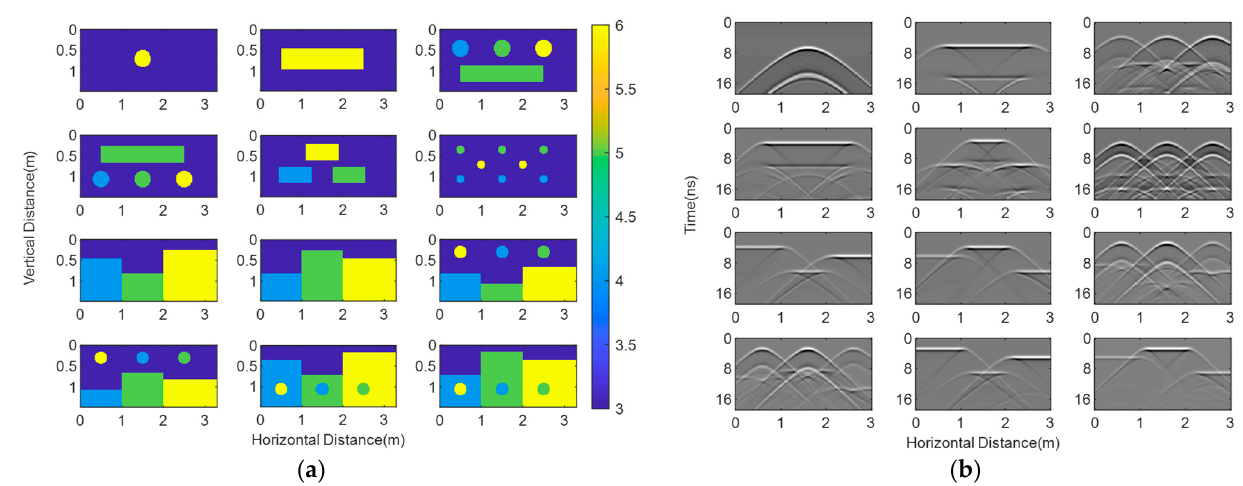
Figure 3. Training models and simulated data. ( a ) Training models. ( b ) Simulated data.